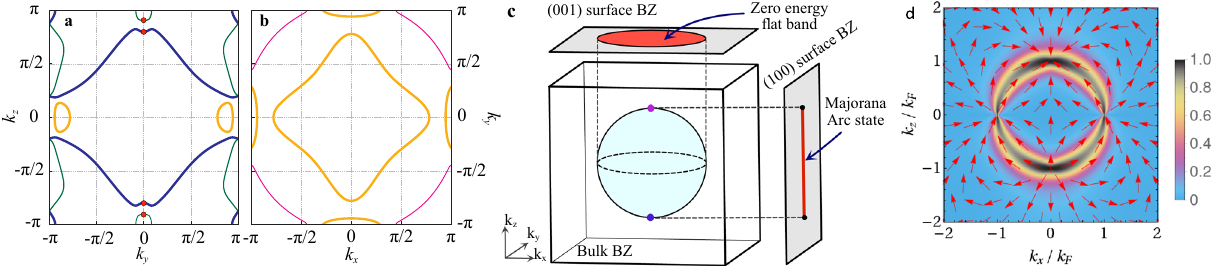
Fig. 4 Properties of the normal and superconducting states of LaPt 3 P. Projections of the four Fermi surfaces of LaPt 3 P with SOC on the y − z plane in a and x − y plane in b . The thickness of the lines are proportional to the contribution of the Fermi surfaces to the DOS at the Fermi level (green — 10.3%, blue — 43.4%, orange — 40% and magenta — 6.3%). The point nodes of the chiral d -wave gap are shown by red dots in a and the line node resides on the x − y plane in b . c Schematic view of the Majorana Fermi arc and the zero-energy Majorana fl at band corresponding to the two Weyl point nodes and the line node respectively on the respective surface Brillouin zones (BZs) assuming a spherical Fermi surface. d Berry curvature F ( k ) corresponding to the two Weyl nodes on the x − z plane. Arrows show the direction of F ( k ) and the colour scale shows its magnitude ¼ 2 π arctan ðj F ð k ÞjÞ . Δ 0 = 0.5 μ was chosen for clarity while a more realistic weak-coupling limit Δ 0 ≪ μ gives a more sharply peaked curvature at the Fermi